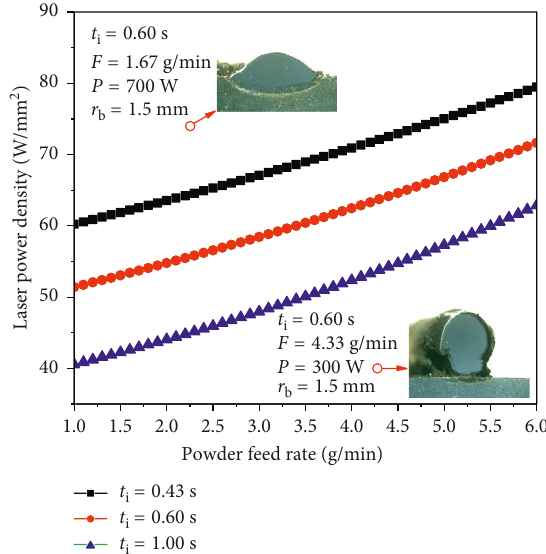
Figure 14: Processing window for laser cladding of Ni-based alloy powder on cast iron substrate in an I vs. F